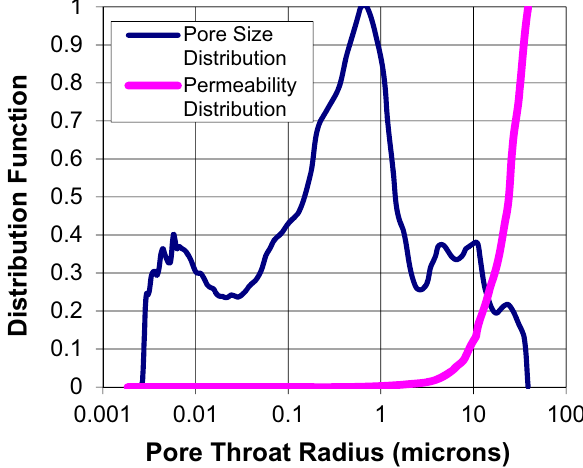
Fig. 4 Pore size and permeability distribution of a float-stone sample from sample depth 2082.05 m (S3